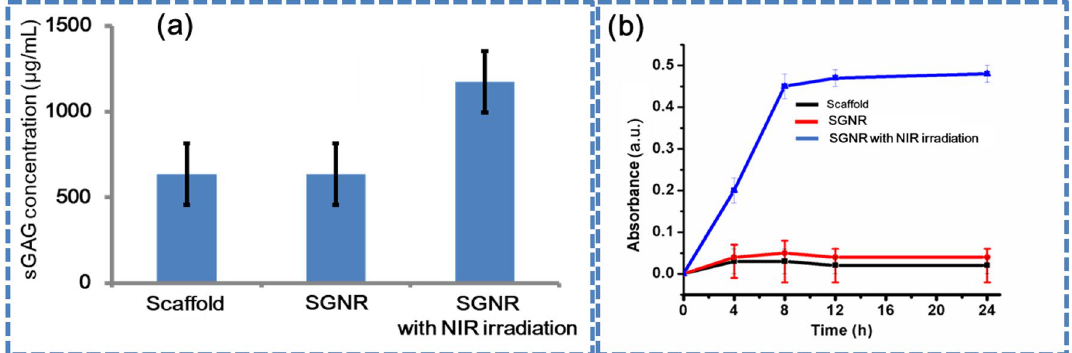
Figure 9. ( a ) sGAG quantitation of rabbit chondrocyte control, with scaffold, immersed in SGNR, and immersed in SGNR and treated with NIR irradiation. ( b ) Absorption profile of BSA at different time with scaffolds, SGNR and SGNR with NIR